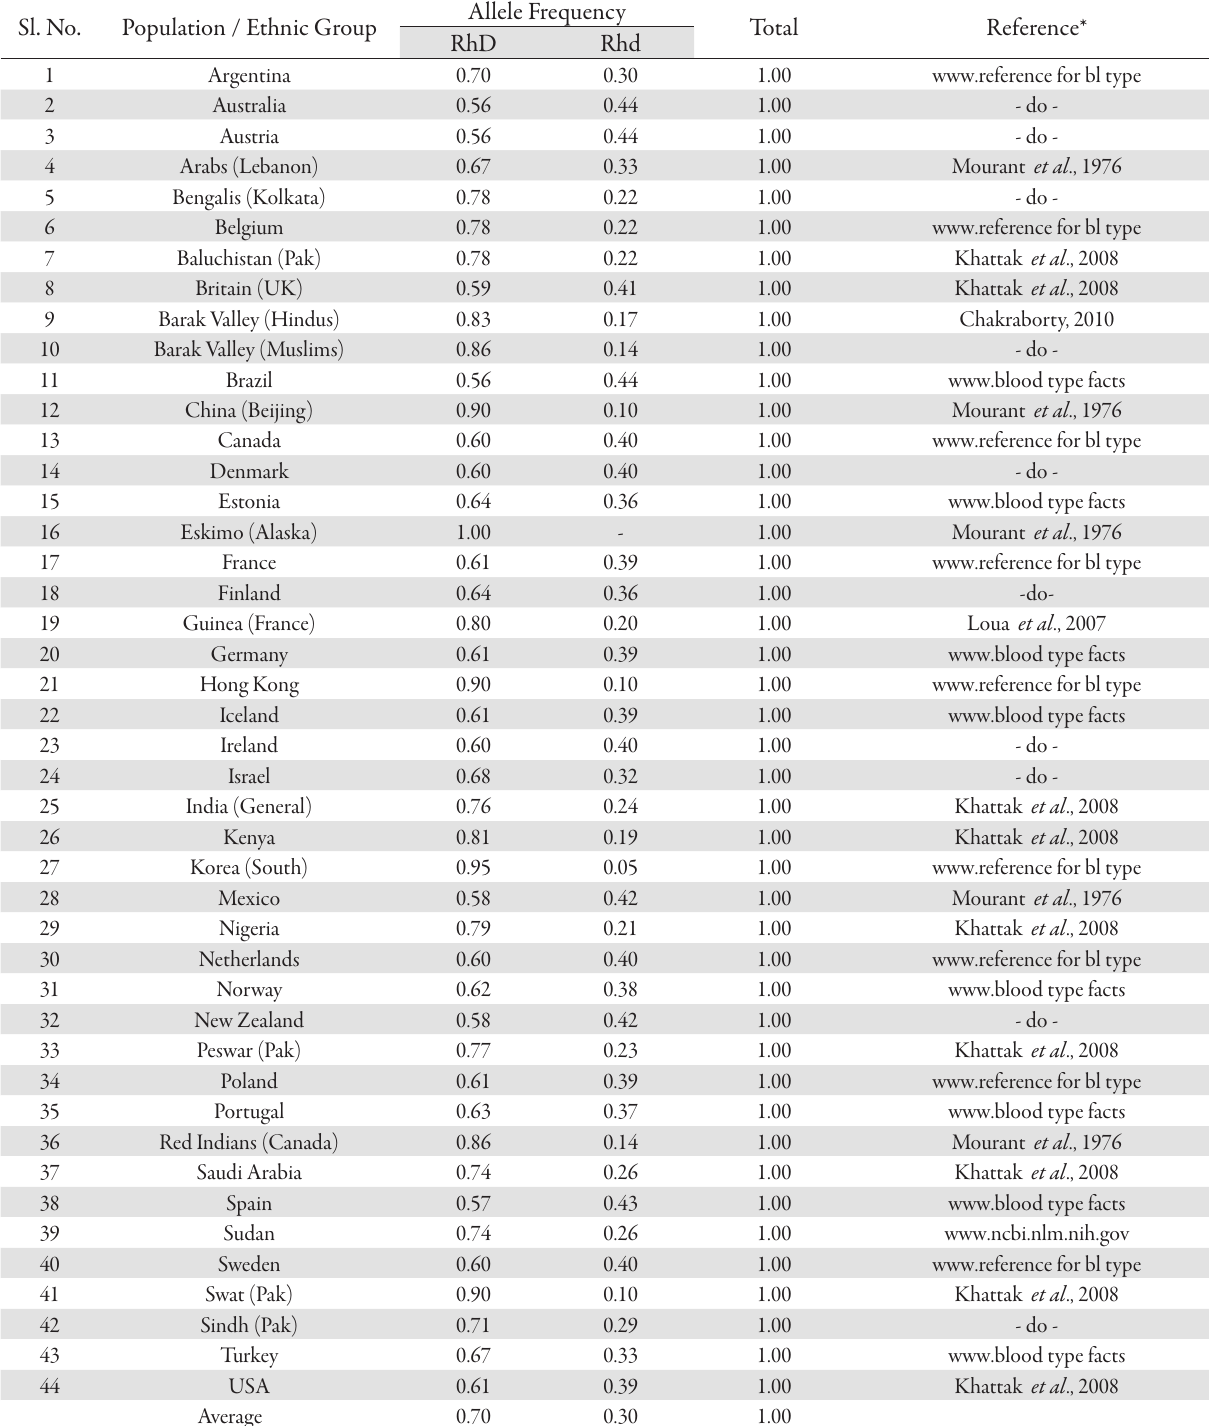
Tab. 1. Estimates of RhD and Rhd allele frequencies of Rh gene in 44 world populations Sl.